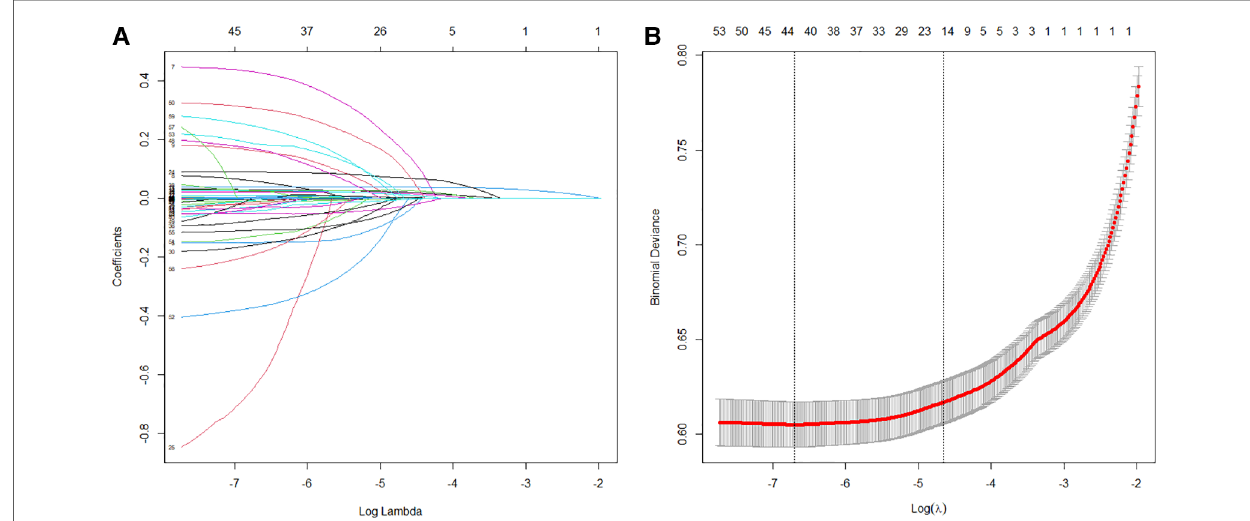
FIGURE 2 Features selection process. Automated feature selection for 57 clinical factors was performed using Least Absolute Shrinkage and Selection Operator, which minimized the loss function binomial deviance, shrank coef fi cients, and produced some coef fi cients that are zero, allowing ef fi cient feature selection ( A ). The algorithm outputted 17 fi ltered features with non-zero coef fi cients that were included in model generation subsequently ( B